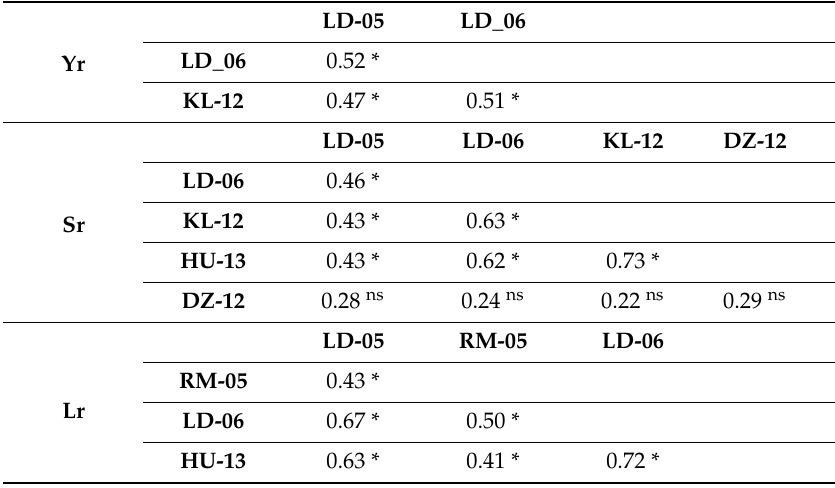
Table 3. Phenotypic correlations among field